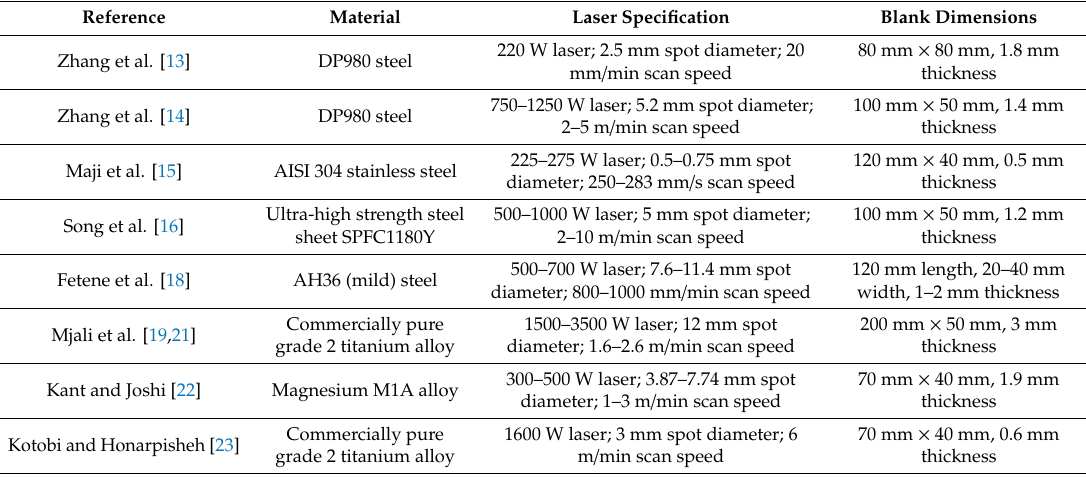
Table 1. Comparison of the leading researches in the laser bending of monolithic